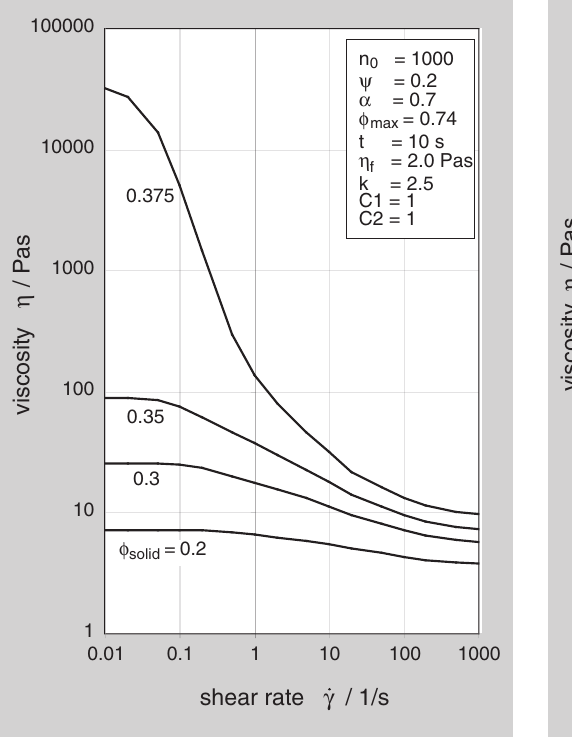
Figure 6 (left): Calculated shear rate dependency of viscosity functions from FIM model (parameter a = fraction of aggregate building particles). Figure 7: Solid volume fraction dependency of viscosity functions from FIM